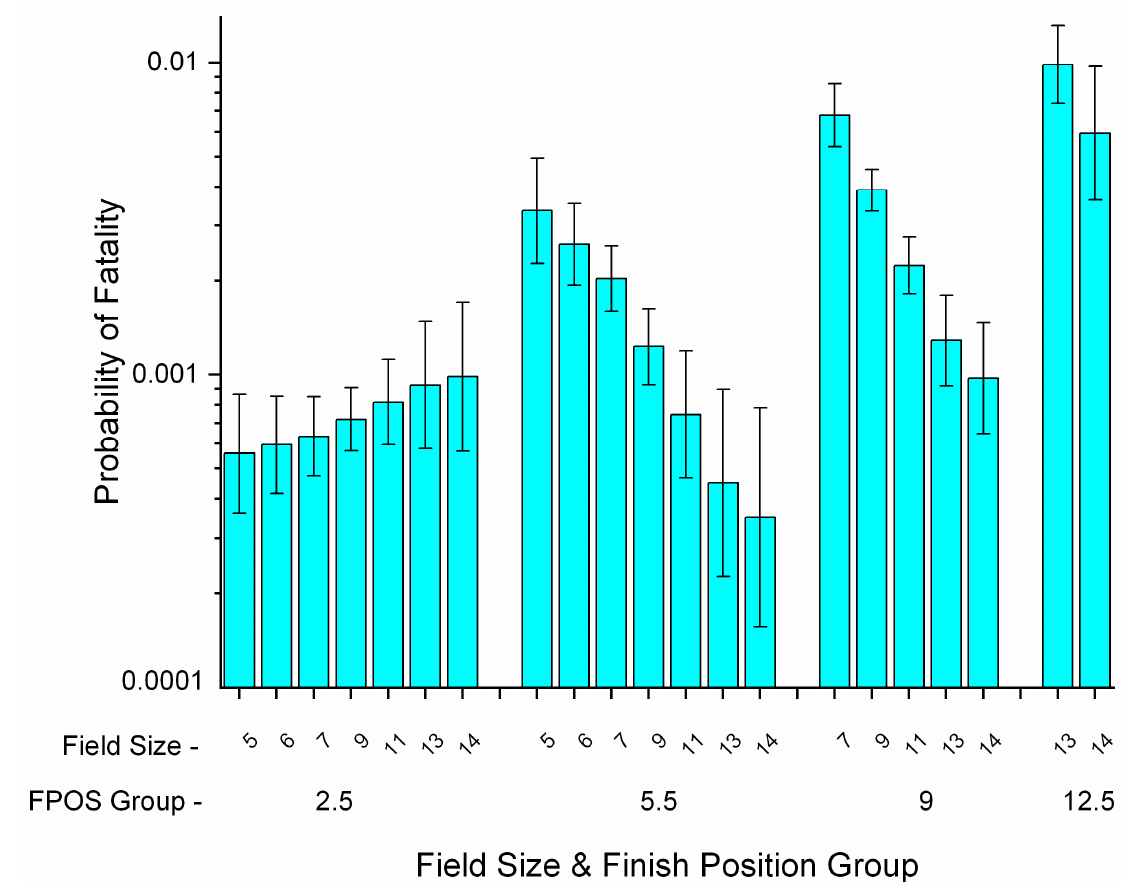
Figure 4. Probability of fatality for Ontario Thoroughbred racehorses for the period 2003–2015 according to results of multivariable logistic regression modelling, unit of interest—race work-event. The graph shows an interaction between finish position (FPOS) group and race field size (RSIZE). Probability of fatality showed a (non-significant) increase with RSIZE for horses in FPOS group 2.5 (positions 1–4). For all other FPOS groups, probability fell within group with increasing RSIZE leading to an overall protective main effect of RSIZE. (Note log scale on y -axis.)